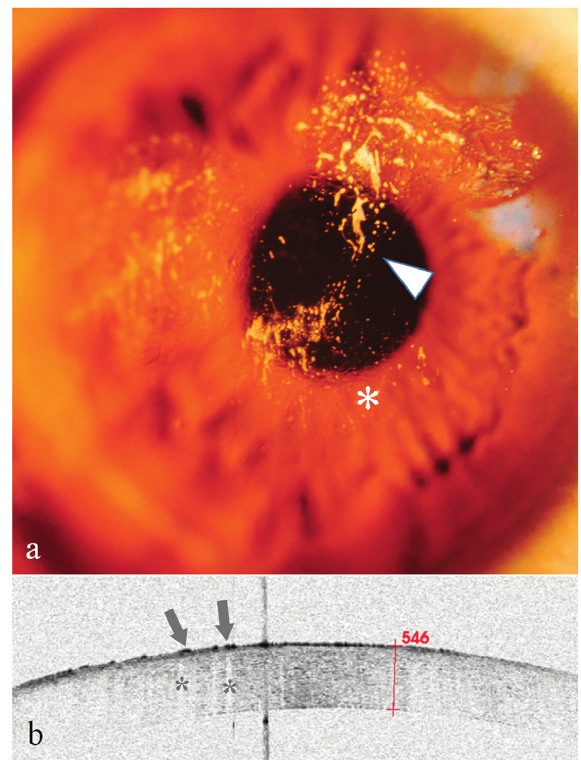
Figure 3: Anterior segment and AS-OCT image for Case 3. (a) Anterior segment photograph: at 9:00 o’clock inside the limbus (arrowhead), a light brown mass was observed without surface fluorescence staining, and fluorescein gathered around the edges. Neovascularization was also seen. (b) AS-OCT image showing that a crescent-shaped low reflective signal (arrowhead) with bilateral marginal zone shadowing (stars) was found 21 μ m below the ep- ithelium